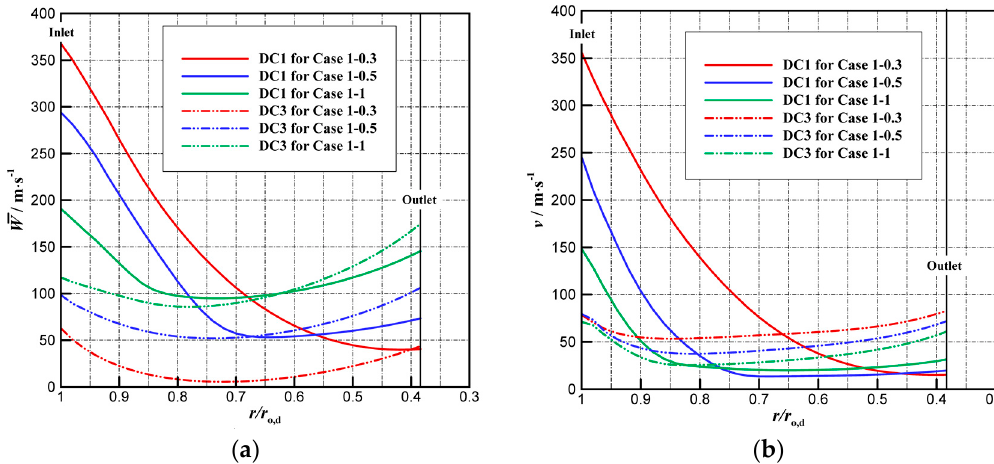
Figure 10. Variation curves of circumferential mass flow average velocity versus the radius ratio for three one-to-one turbine cases: ( a ) relative tangential velocity; and ( b ) radial